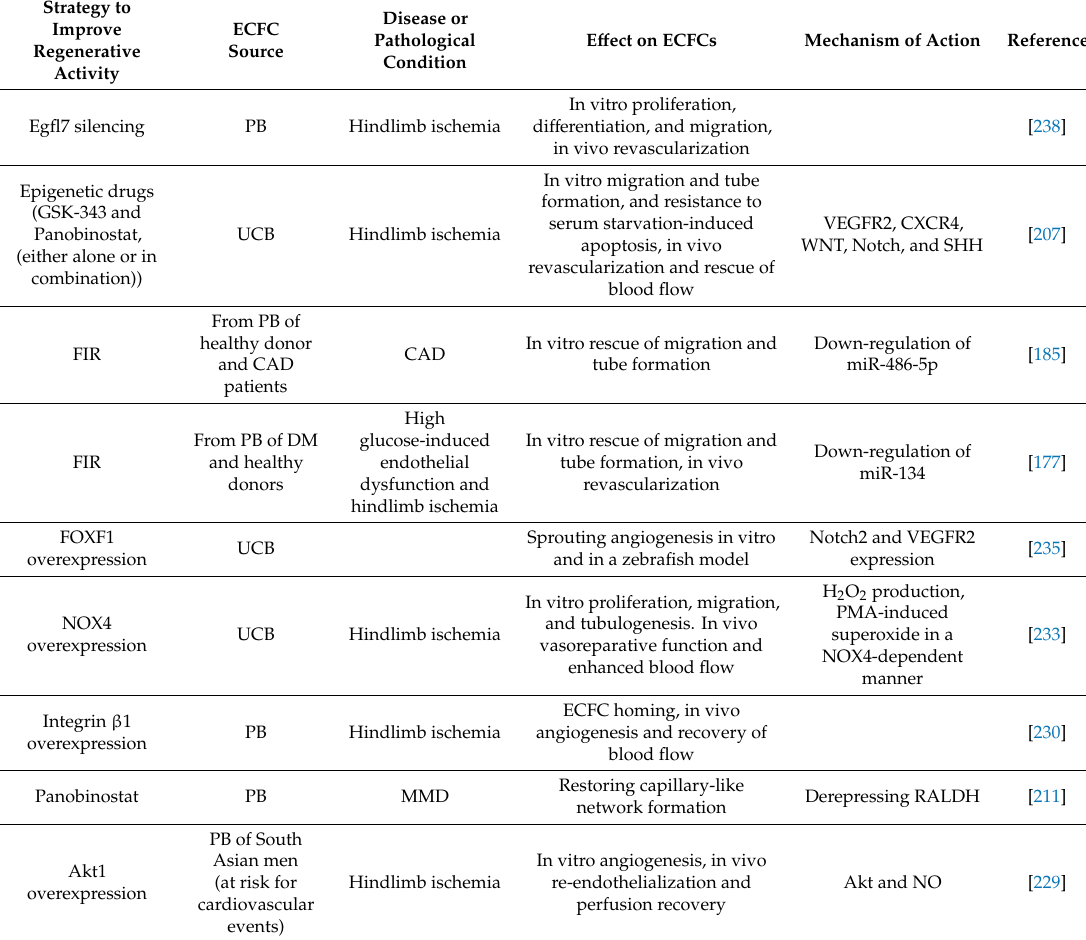
Table 6. Epigenetic and genetic modulation of ECFCs to rescue their angiogenic